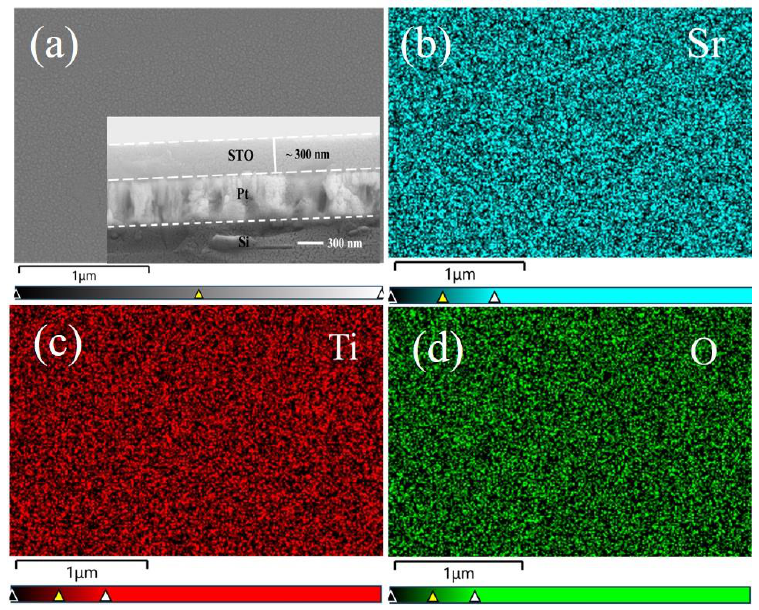
Figure 3. SEM characterizations of the STO thin film at 650 °C: ( a ) surface and cross-sectional morphologies, ( b – d ) EDS mappings of Sr, Ti and O elements.